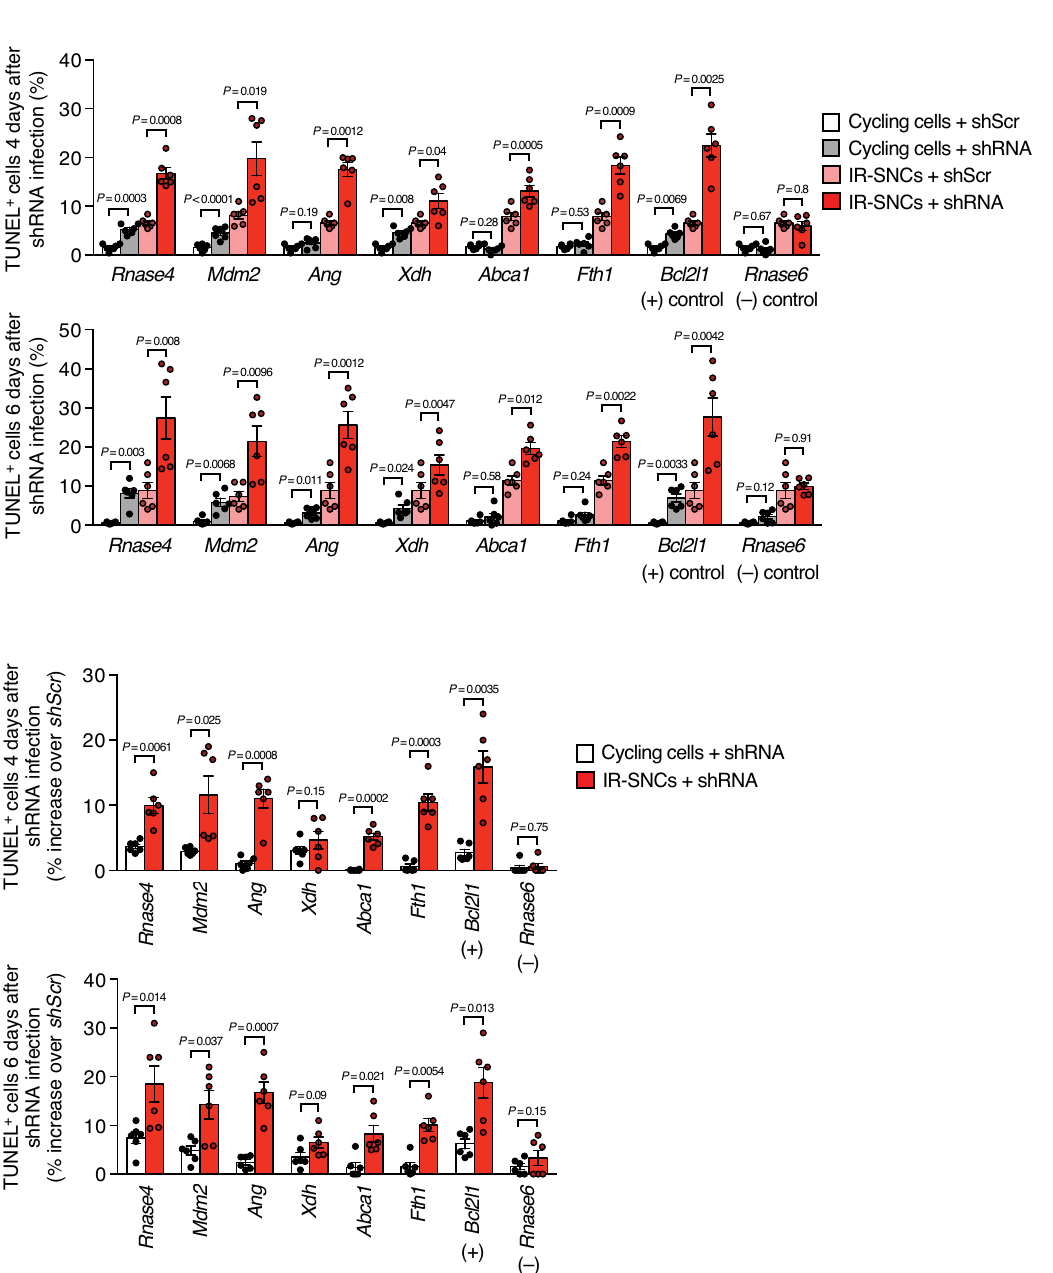
Fig. 3 SASE genes implicated in SNC survival have limited impact on the viability of cycling cells. a Quanti fi cation of TUNEL-positive IR-senescent or proliferating cells 4 or 6 days after shRNA-mediated SASE gene knockdown. We note that due to the experimental setup some shScr control values are used for several comparisons when they were assessed in the same experiment. b Increase in TUNEL-positive cells 4 and 6 days after lentiviral infection relative to cells containing scrambled shRNA. Data from a were used for this calculation. Data represent means ± SEM. n = 6 independent MEF lines pooled from 2 independent experiments in a , b . Statistics: one-way ANOVA with Sidak ’ s correction in a , paired, two-tailed t -tests in b . Source data are provided as a Source Data fi